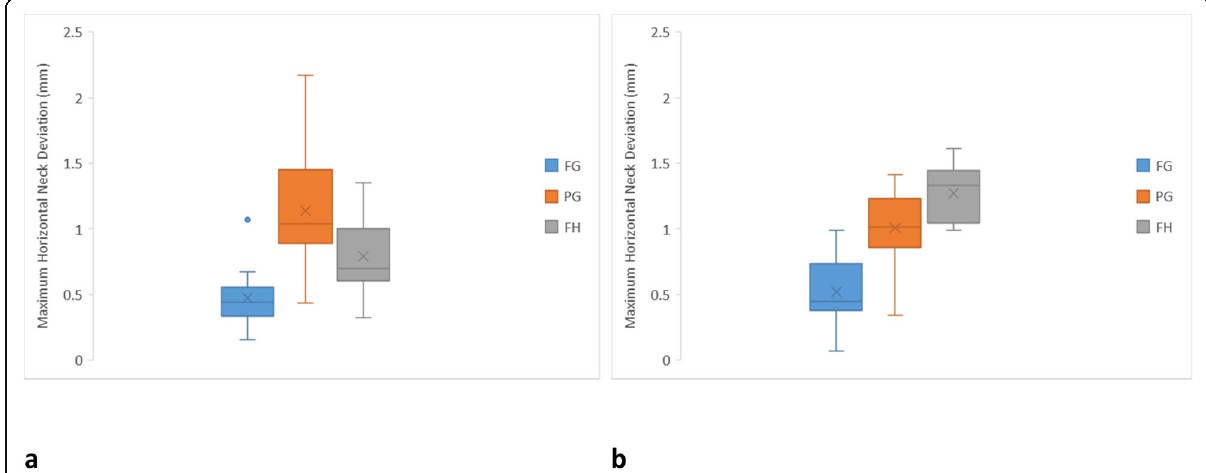
Fig. 4 Box plot diagrams illustrating the distribution of maximum horizontal neck deviation of each protocol. a Anterior implants. b Posterior